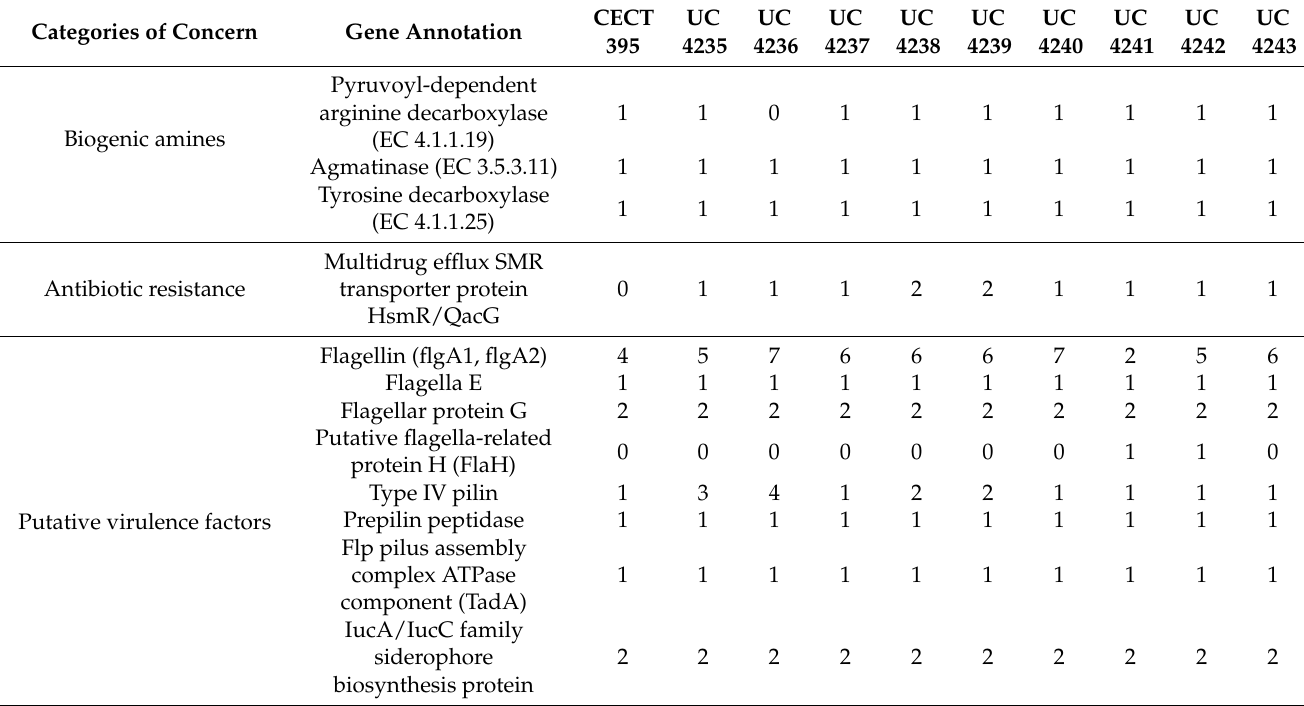
Table 3. Genes of concern in H. salinarum food